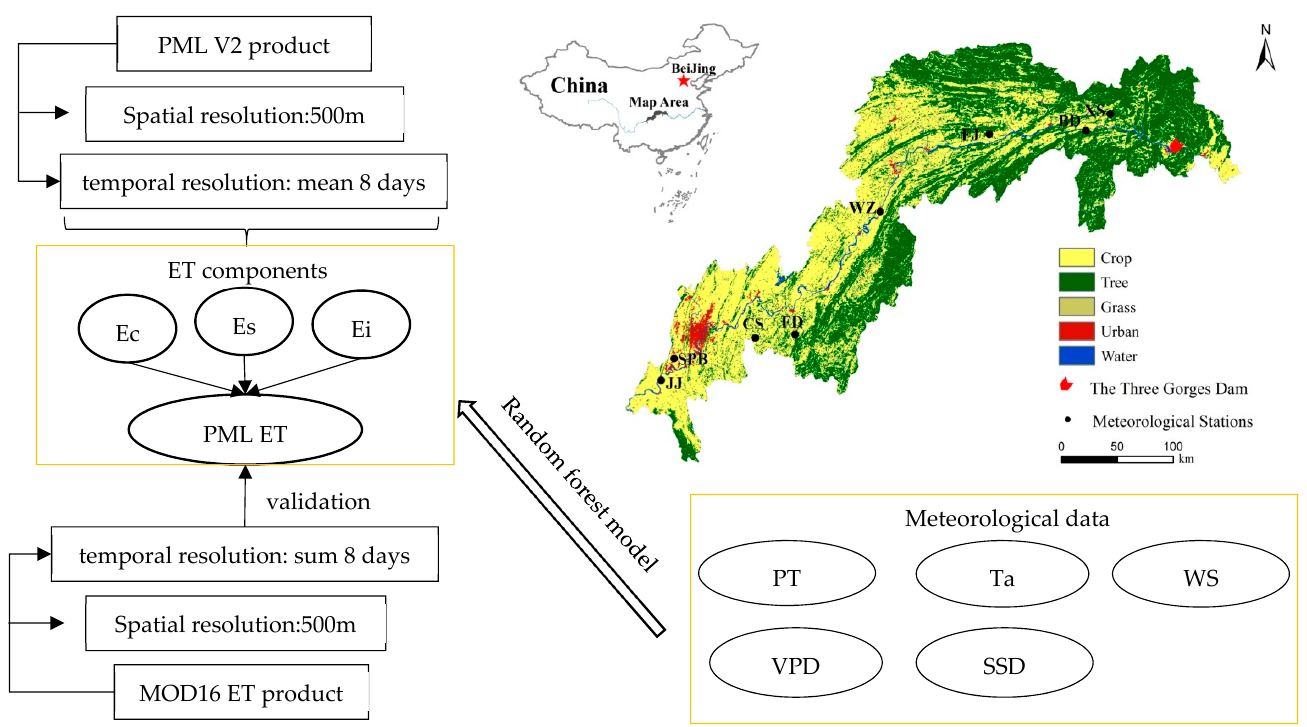
Figure 1. The overall framework, study area, and location of meteorological stations.